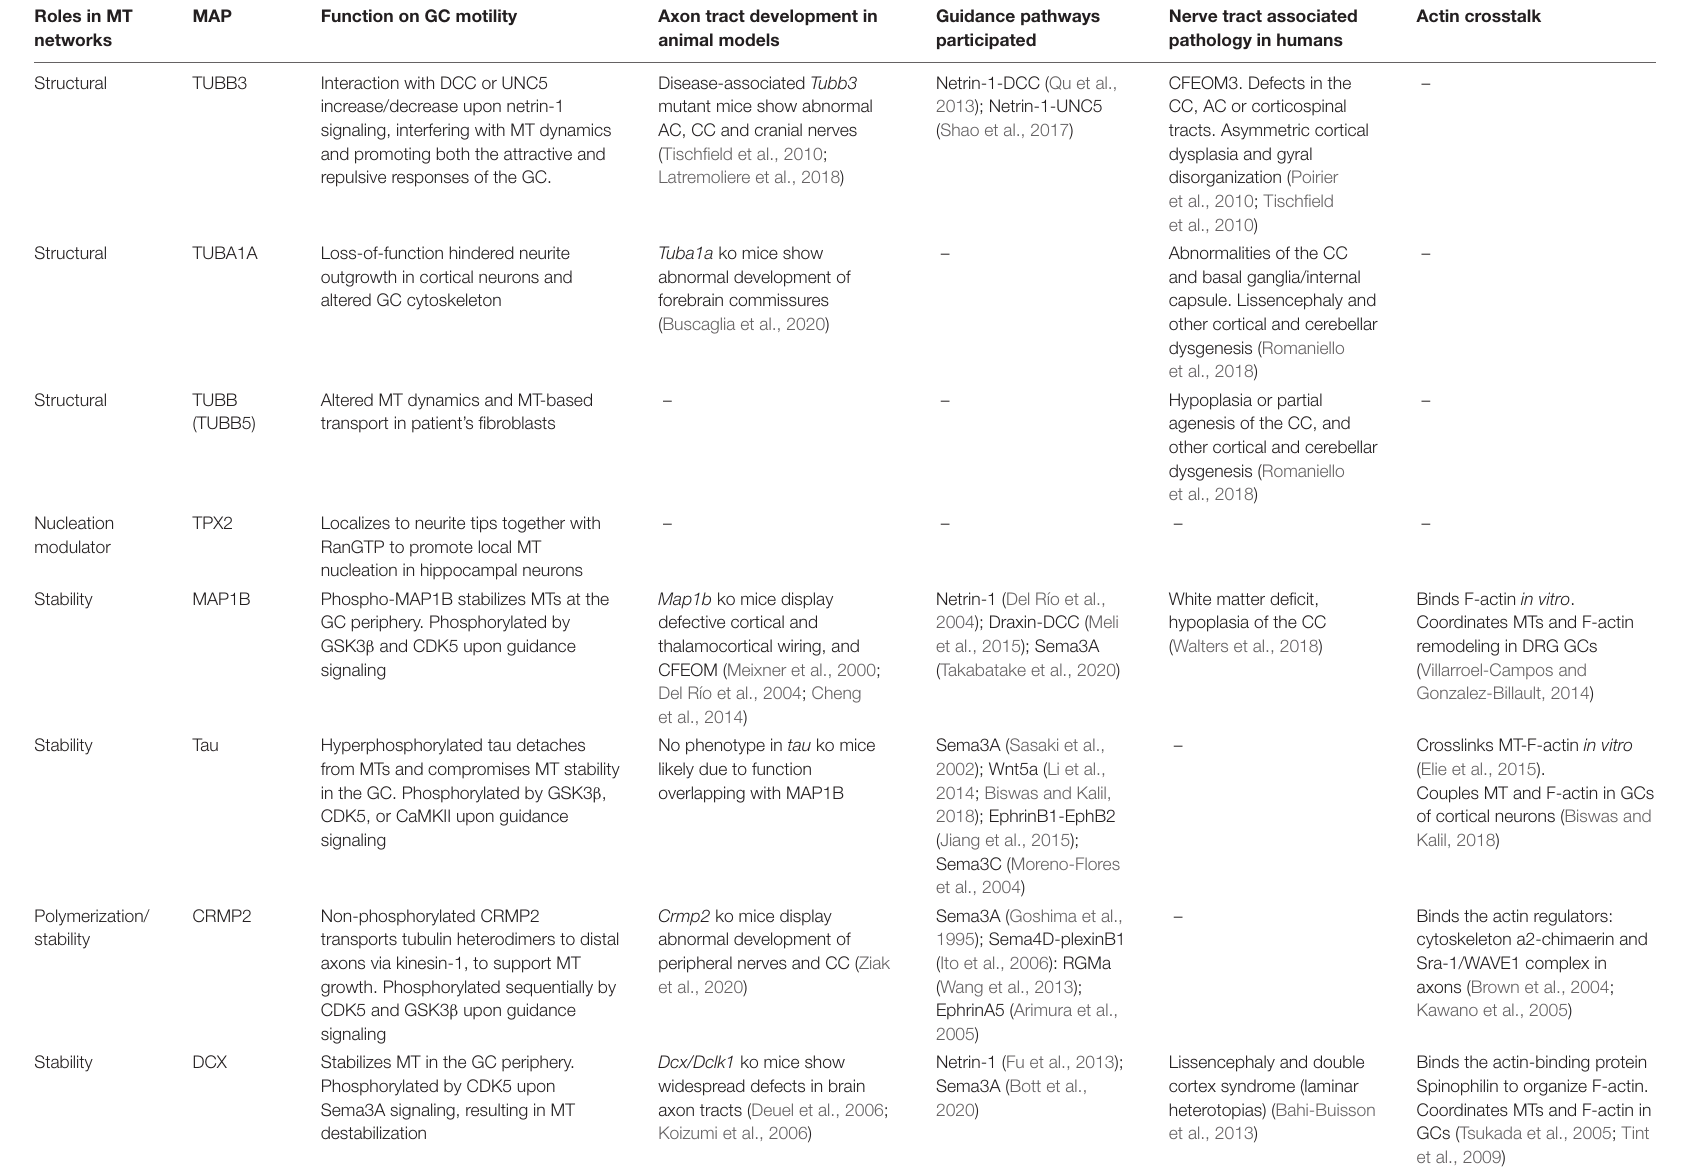
TABLE 1 | Links of microtubule-associated proteins (MAPs) with axon